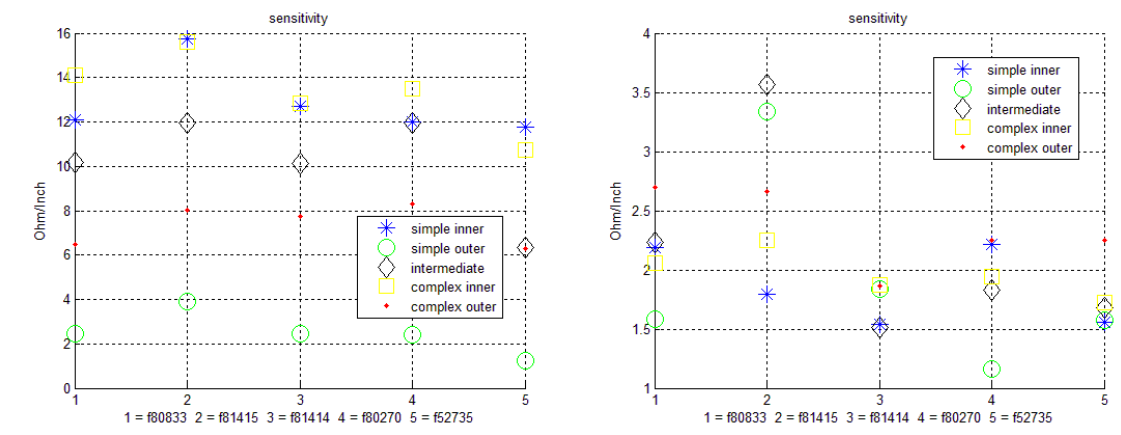
Figure 12. Sensitivity: ( left ) un-insulated case; ( right ) insulated case.